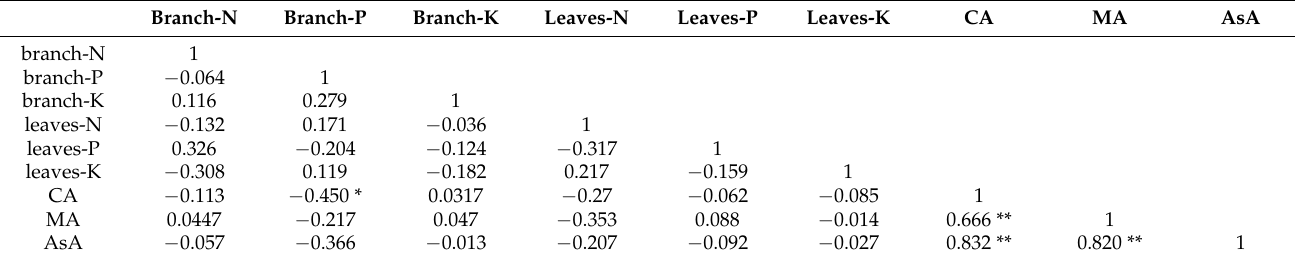
Table 4. Pearson correlation coefficient matrix of NPK content in branches and leaves and fruit organic acid content under different fruit load